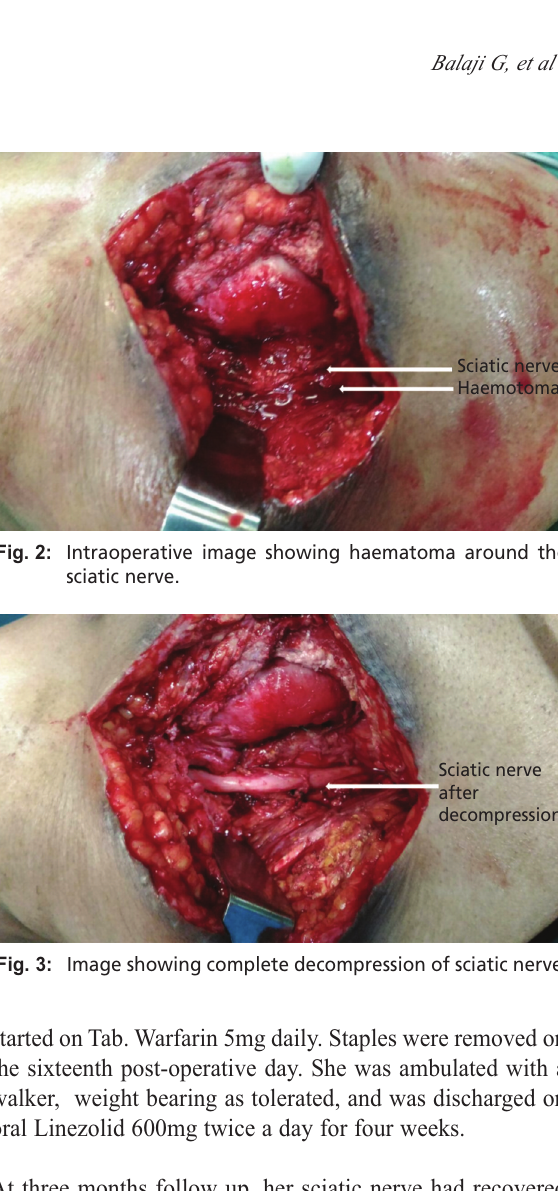
Image showing complete decompression of sciatic nerve. Fig. 3: